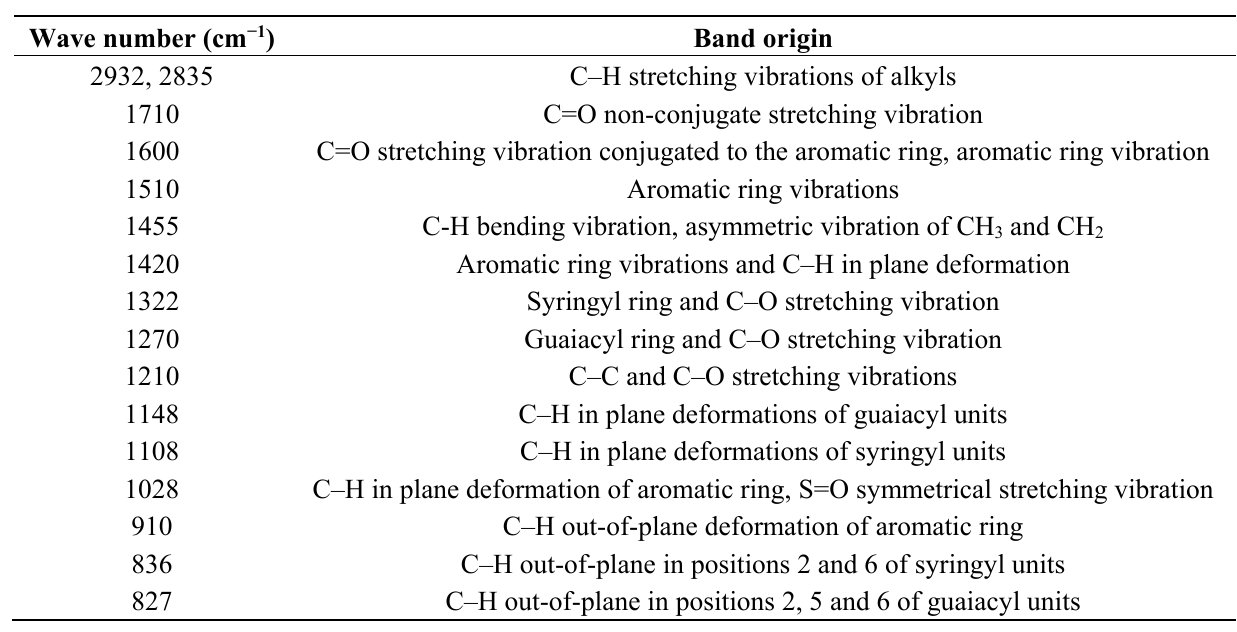
Table 2. The FTIR analysis of lignin